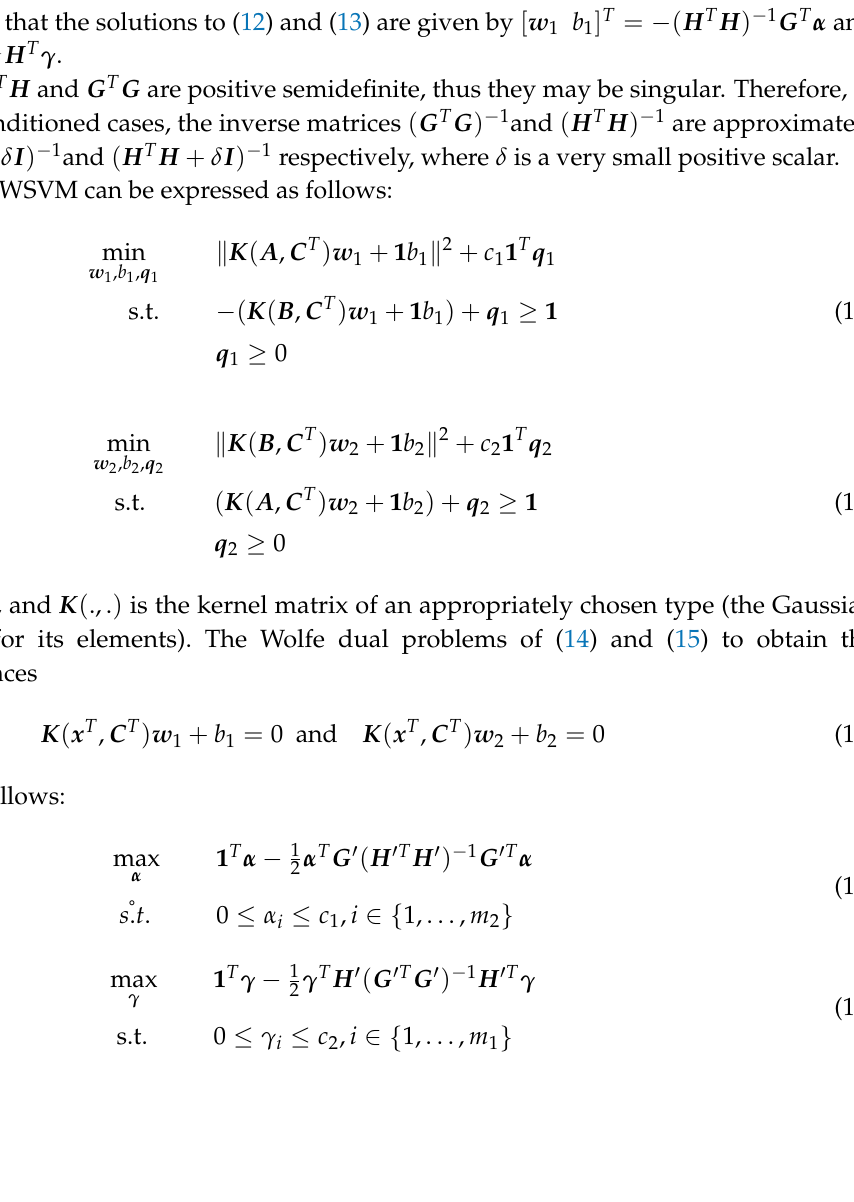
Figure 3. Geometric interpretation of Twin Support Vector Machine